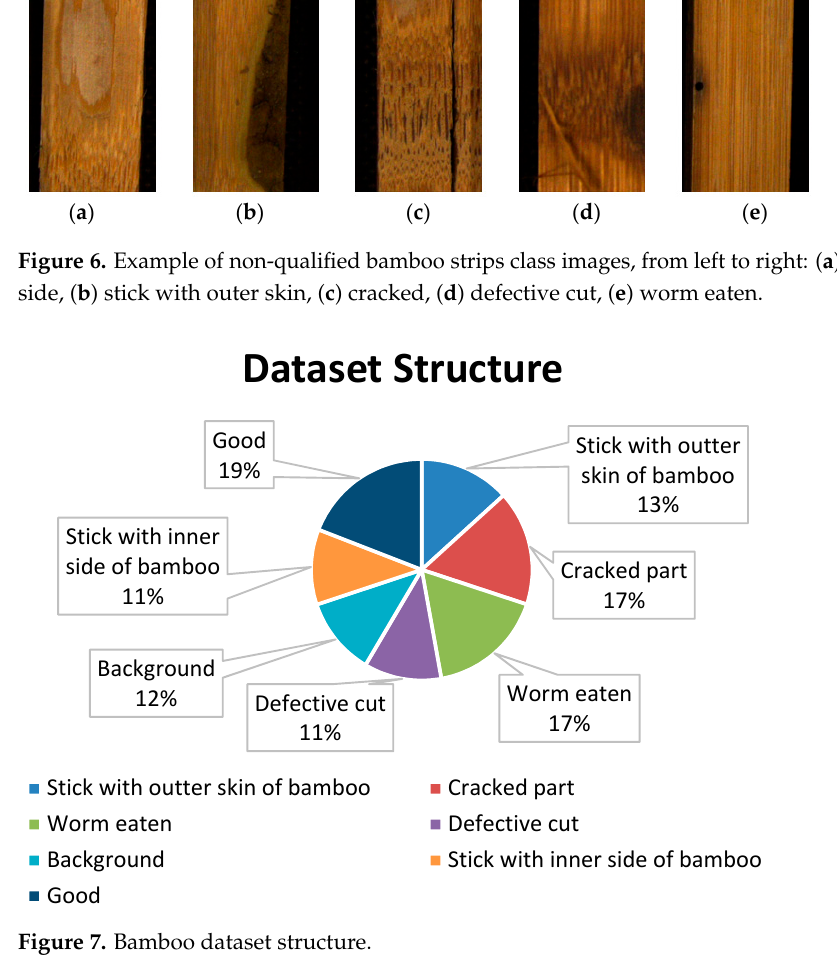
Figure 7. Bamboo dataset structure.